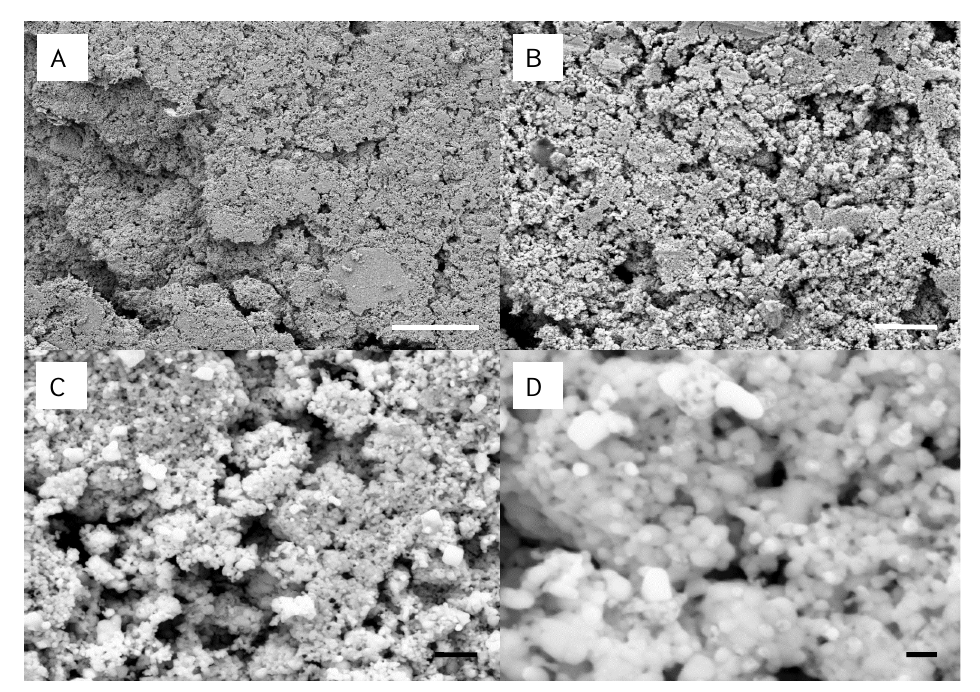
Figure 4. Representative SEMs of the surface of an etched 10 wt% SiO 2 -Ag composite similar to those presented in Figure 1; scale bars of ( A ), ( B ), ( C ) and ( D ), respectively correspond to 100 μm, 10 μm, 1 μm and 100